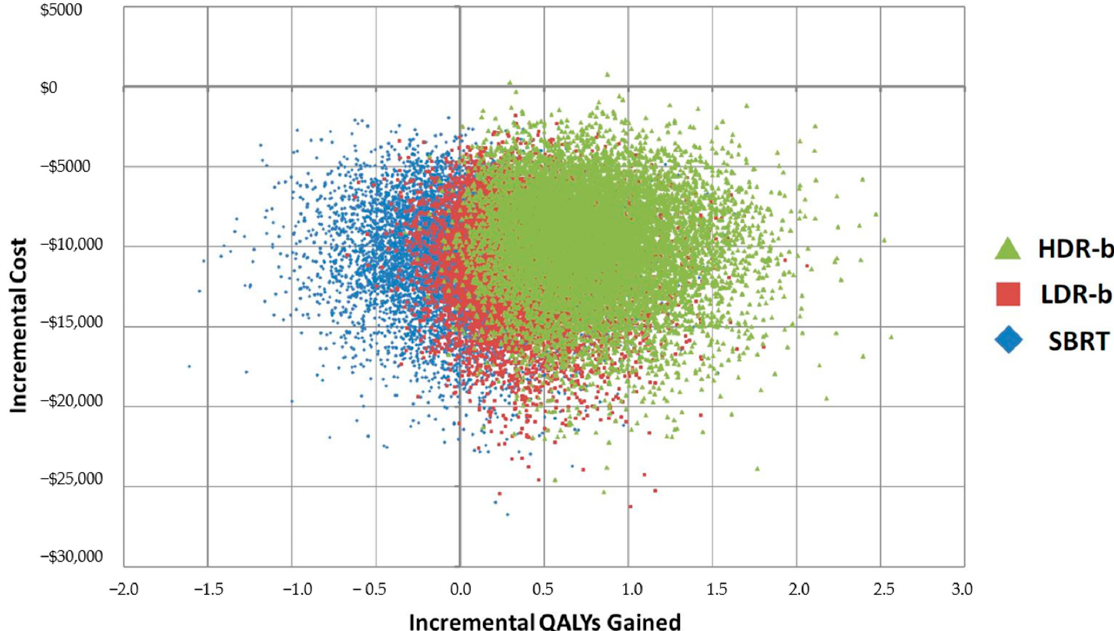
Figure 2. Cost-effectiveness plane, incremental results for top 3 treatment modalities. HDR-b = high-dose-rate brachytherapy monotherapy; LDR-b = low-dose-rate brachytherapy monotherapy; SBRT = stereotactic body radiotherapy; QALY = quality-adjusted life year.